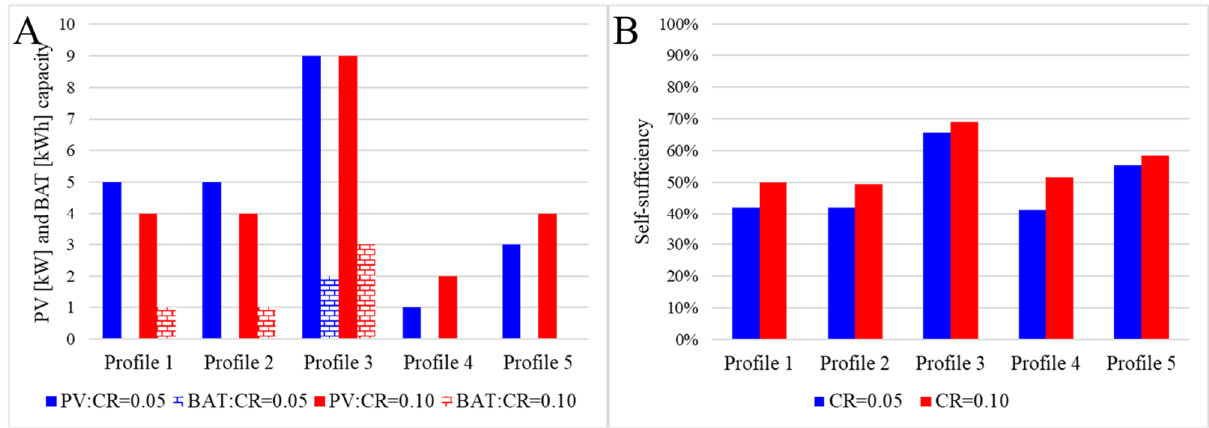
Figure 6. PV–battery (BAT) capacity ( A ) and self-sufficiency ( B ) in Madrid, assuming self-sufficiency maximisation.